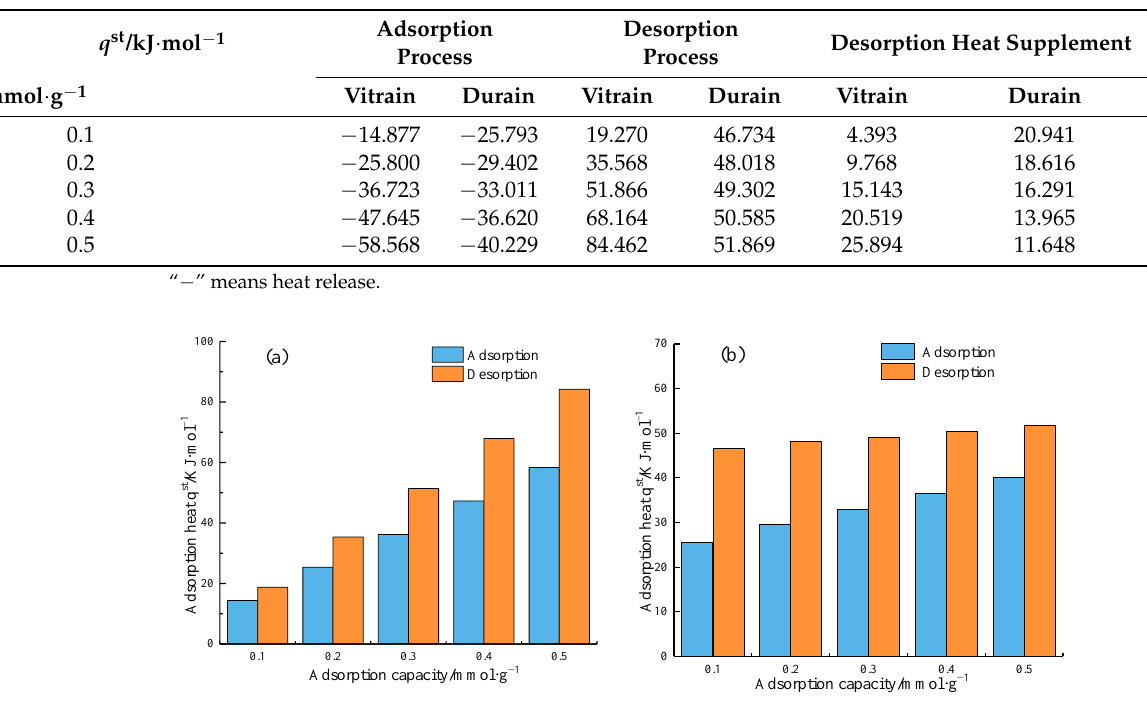
process. Table 11. Calculation results of the isosteric heat of vitrain and durain samples.